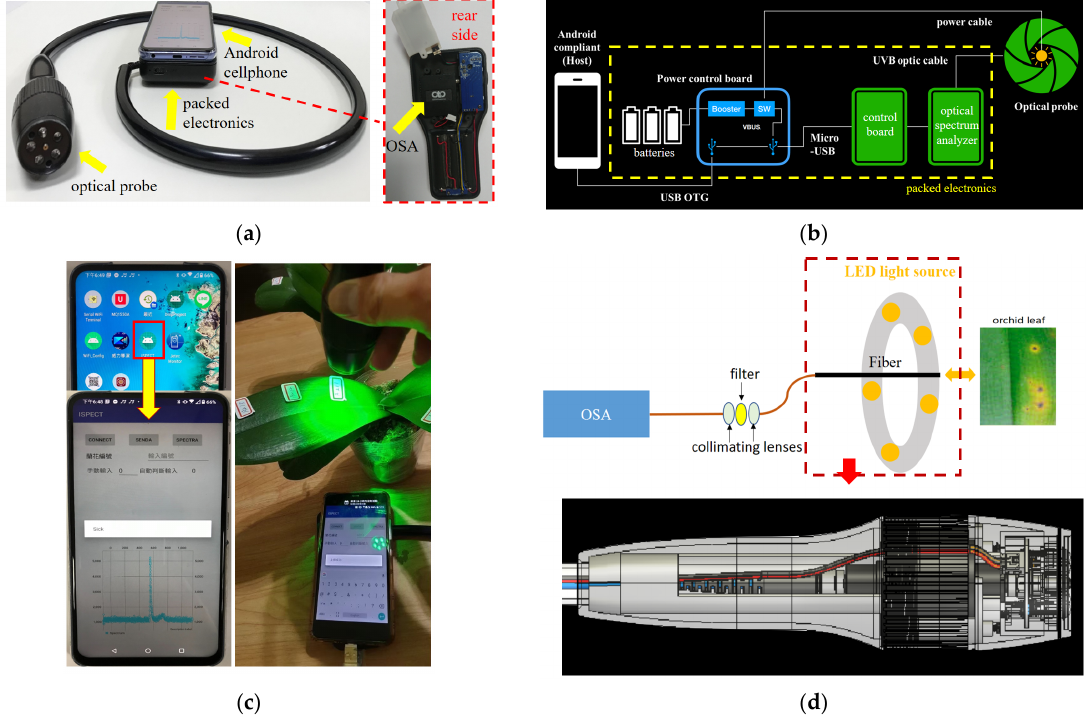
Figure 2. Handheld artificial intelligence (AI) and Internet of Things–based inspection platform. ( a ) Photograph of the system. ( b ) Schematic of the system. ( c ) Icon and main panel of the app, displaying the leaf spectrum under green-light excitation, as measured by the optical probe. ( d ) Schematic of the optical probe and components of the inspection platform.